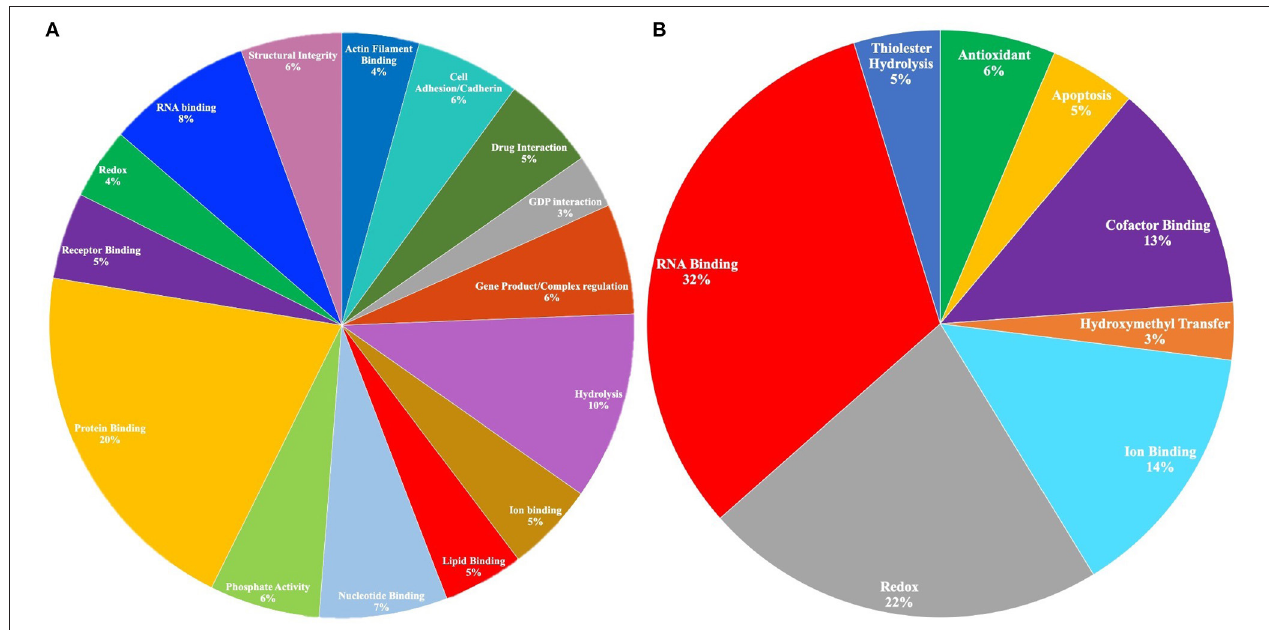
FIGURE 2 | (A) Gene Ontology (GO) molecular functions of proteins with decreased abundance in fragile X-associated tremor/ataxia syndrome (FXTAS) ( p < 0.05). A total of 301 proteins were submitted in the original query, and 97 proteins were associated with GO molecular functions. Only the functions associated with > 1% of the proteins in the query are depicted in the chart. (B) GO molecular functions of proteins with increased abundance in FXTAS ( p < 0.05). A total of 121 proteins were submitted in the original query, and 10 proteins were associated with GO molecular